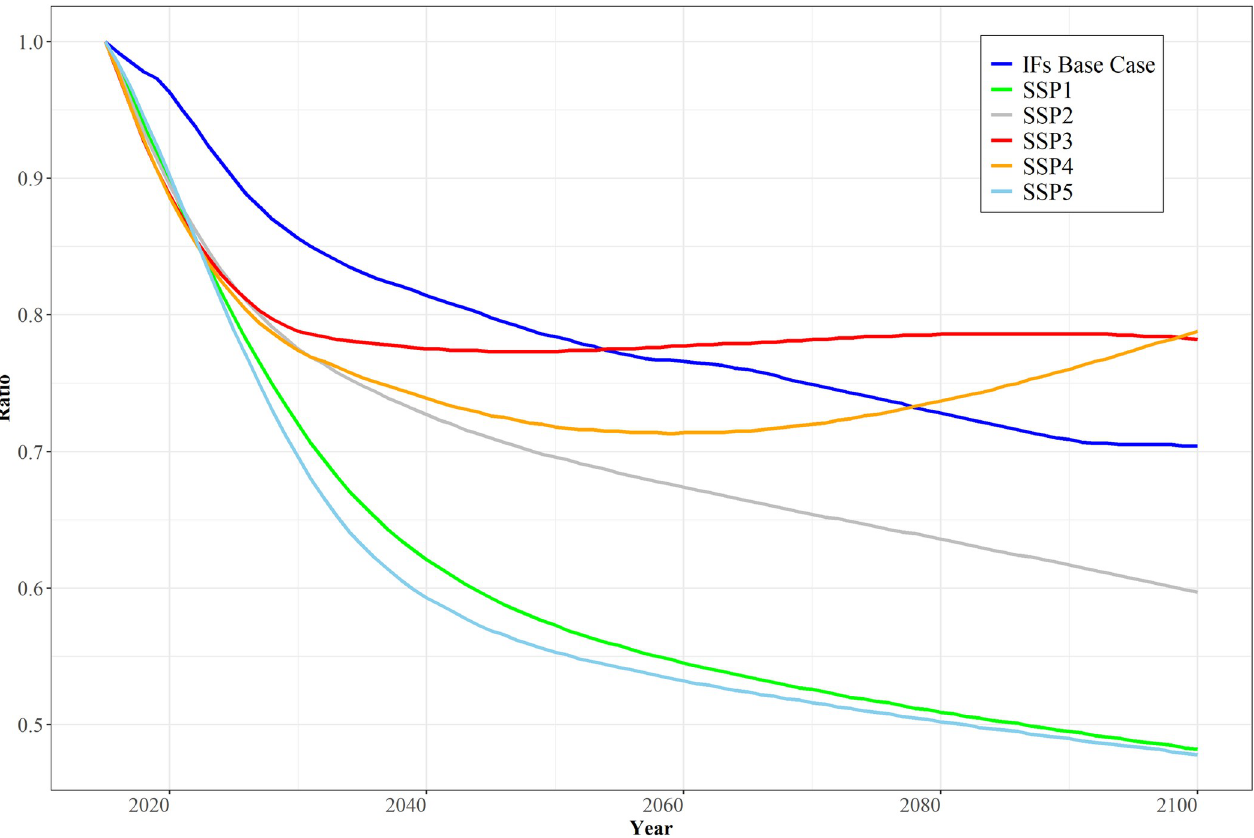
Fig 4. Ratios of OECD and non-OECD TFP projections in the OECD SSP scenarios and in the Base Case projections from IFs. Notes: Country aggregation uses GDP-weighting. Ratios are indexed to 1 in 2015 facilitate comparison across the models; absolute OECD values remain significantly above those in non-OECD countries. Source: OECD courtesy of Rob Dellink and Jean Chaˆteau; IFs Version